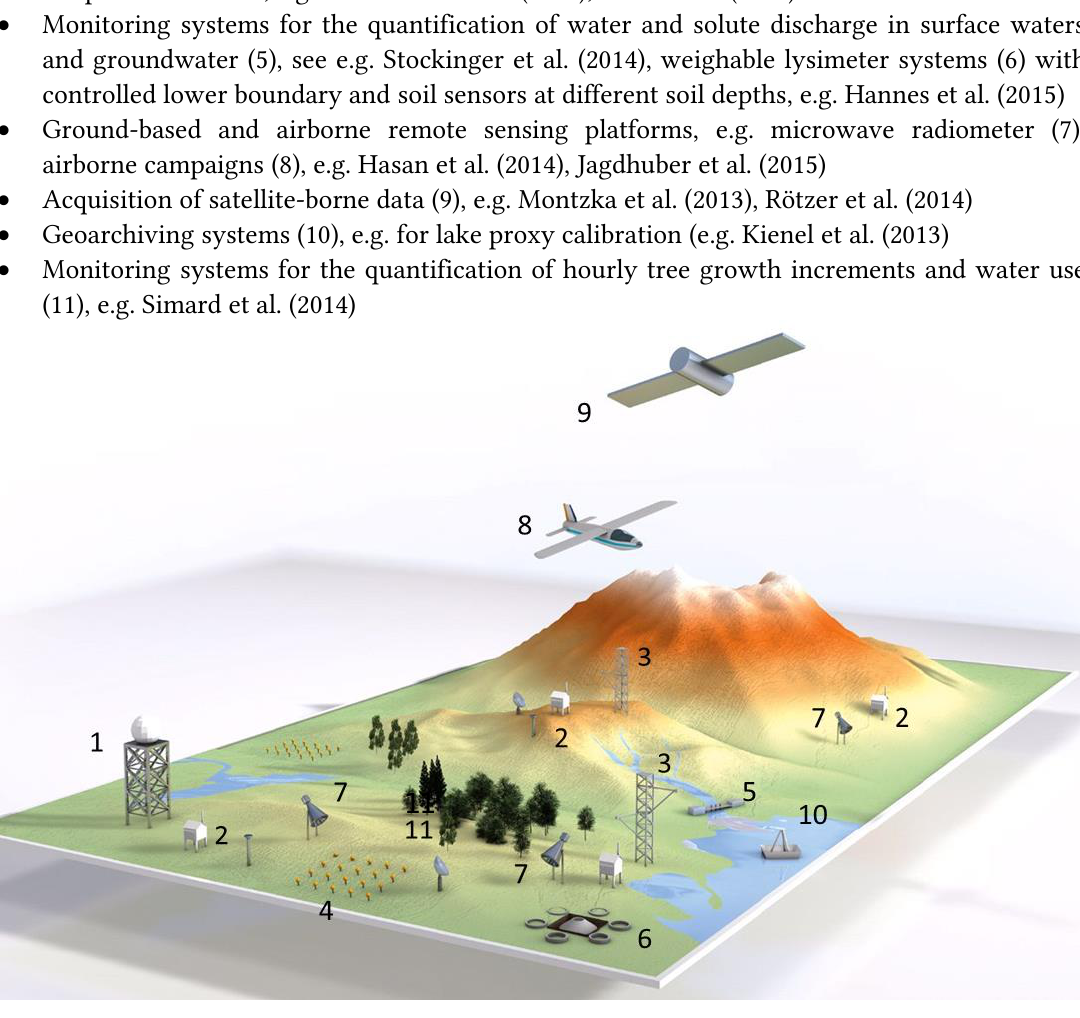
Figure 2: Schematic view of a typical TERENO observatory platform (see text for more